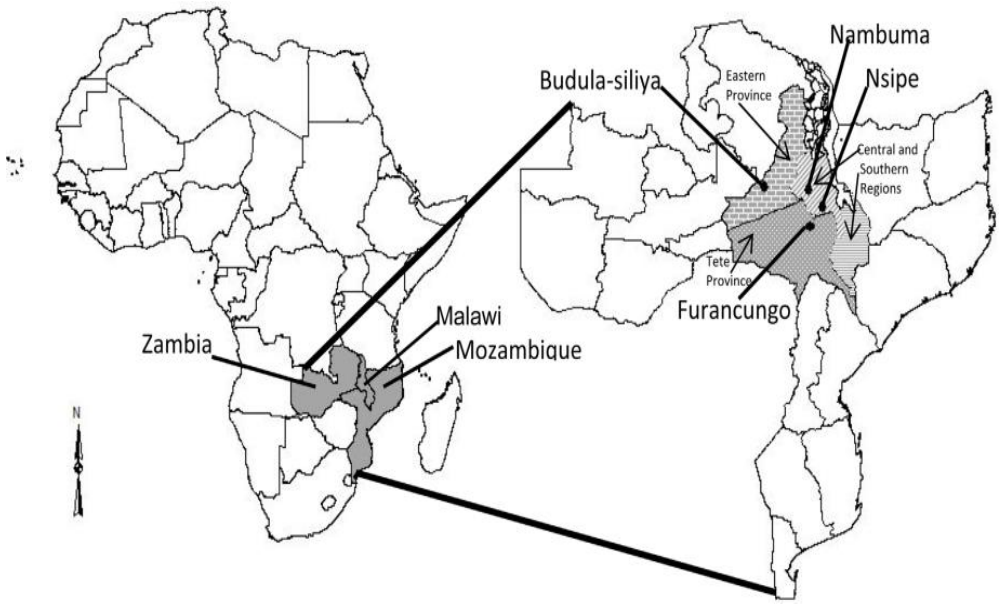
Figure 1. Map showing the Chinyanja Triangle, covering the Tete province of Mozambique, the Eastern province of Zambia, and the Central region of Malawi. Reproduced from Mponela et al. [42] with permission from Elsevier, 2016. Specific coordinates (latitude, longitude) for the specific study sites shown, are as follows; Budula–Siliya (13.7567° S, 31.9566° E), Nambuma (13.7035° S, 33.5976° E), Nsipe (14.1832° S, 34.1254° E), Furacungo (14.9114° S, 33.6232° E).